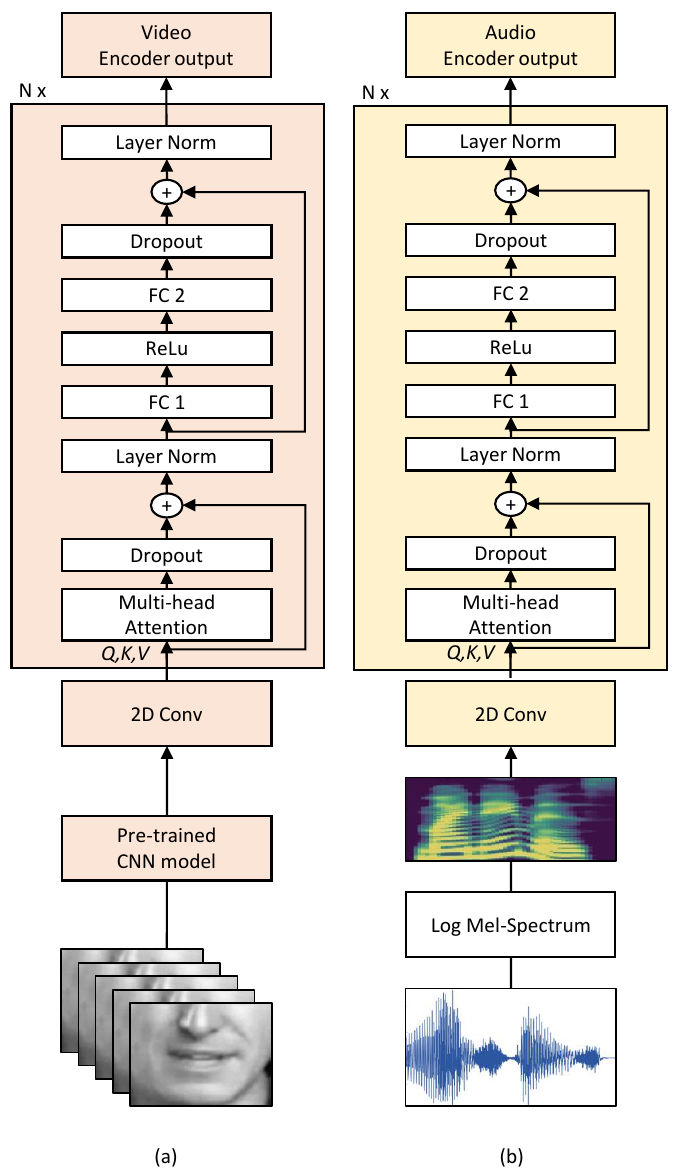
Figure 2. Encoder structures. Each structure generates audio or video features using a multi-head self attention followed by two feed-forward layers (FC 1 and FC 2). The number of encoder blocks, N , is six in these structures. ( a ) Video encoder; ( b ) audio